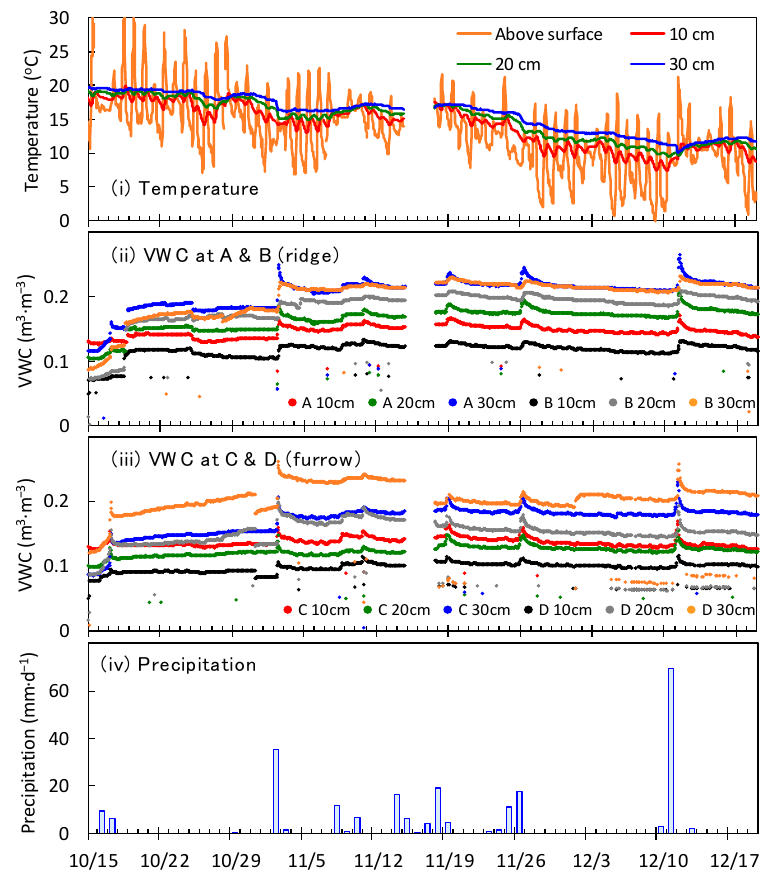
Figure 7. Temperatures above the surface and at 10, 20, and 30 cm depths measured with the developed sensor A ( i ), volumetric water content (VWC) measured in ridges ( ii ), and in furrows ( iii ), and precipitation ( iv ) at the grape field from 25 October to 19 December 2015.